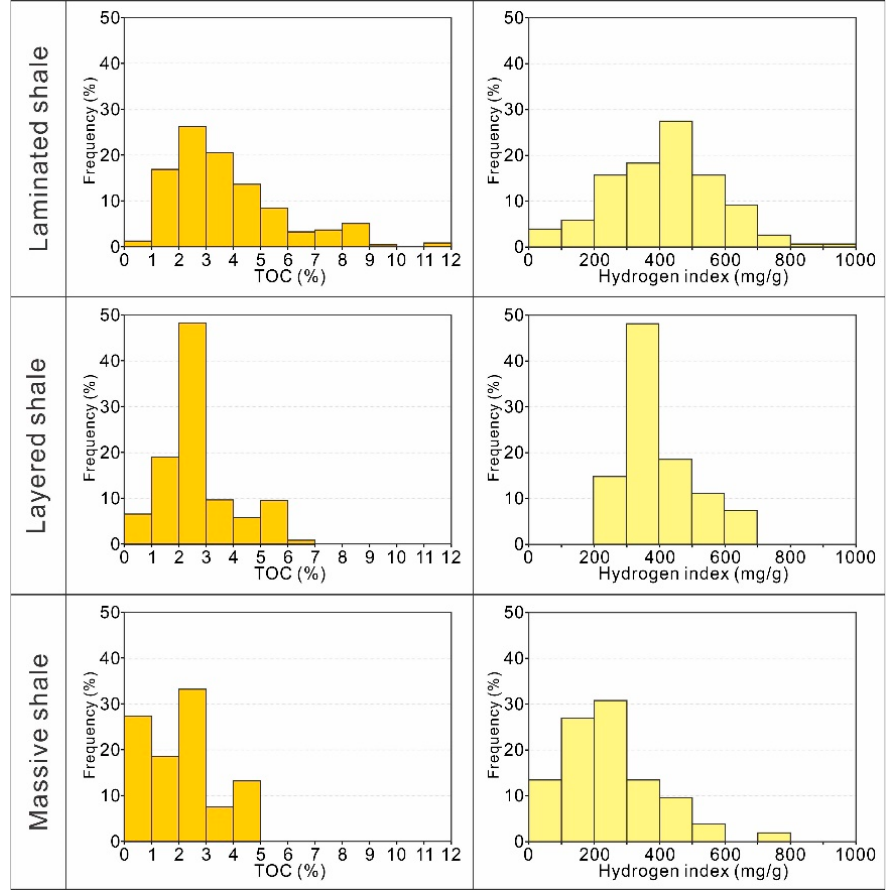
Figure 4. Distribution characteristics of TOC and hydrogen index for different types of shale. Date